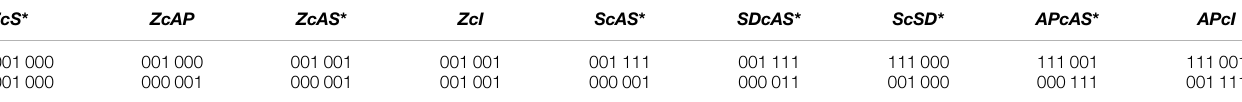
TABLE 2 | Matrix form of 2 TR -periodic CONNECT states (* asymmetrical states). The existence regions of each state are located between the existence regions of speci fi c MAIN states ( Figure 1F ). CONNECT states were named to indicate the branches of such MAIN states interspersed by the letter c . For example, the existence region of state APcAS islocatedbetweenstates AP and AS .NamescontainingtheletterZindicatethattheyconnectbranchesofzerosolutions(whichcannotappearinthesystemfor our parameter constraints).